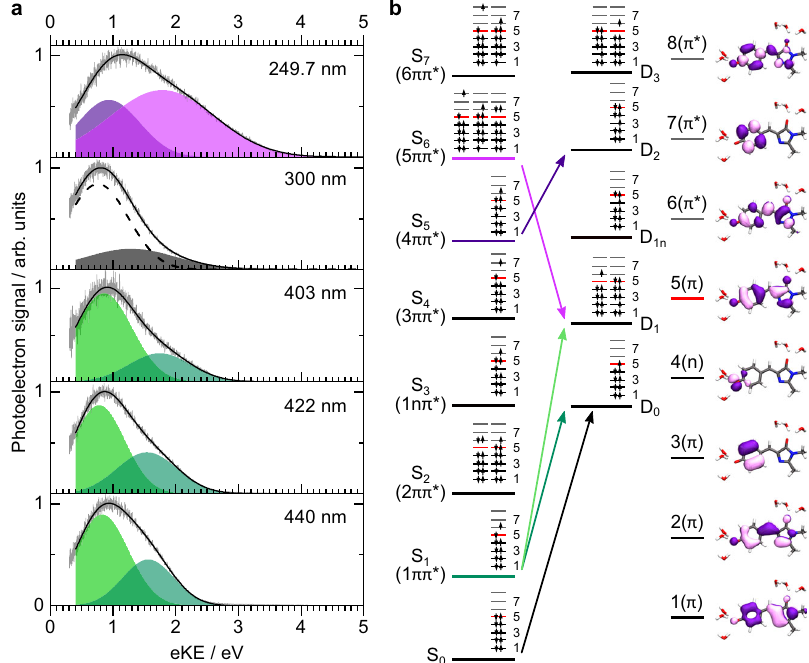
*)S ! e (cid:2) ð g Þ aq Þ Table 2. The fi rst VDE has been calculated using a hybrid DFT/ and polar water molecules. It converges for a system with ~12,500 water molecules ( R = 40 Å, Supplementary Fig. 8). The equilibrium geometry of this system is then used to calculate the lowest-lying D 0 and D 1 VDEs using the XMCQDPT2/SA(10)-CASSCF(14,14)/ (aug)-cc-pVDZ + //EFP approach. The calculated VEEs are affected less by the size as the system is still negatively charged after pho- toexcitation. VDEs of the higher-lying doublet states have been calculated at the XMCQDPT2/SA(10)-CASSCF(15,14)/(aug)-cc- pVDZ//EFP level of theory with respect to D 0 . The VDEs are also listed in Table 2.